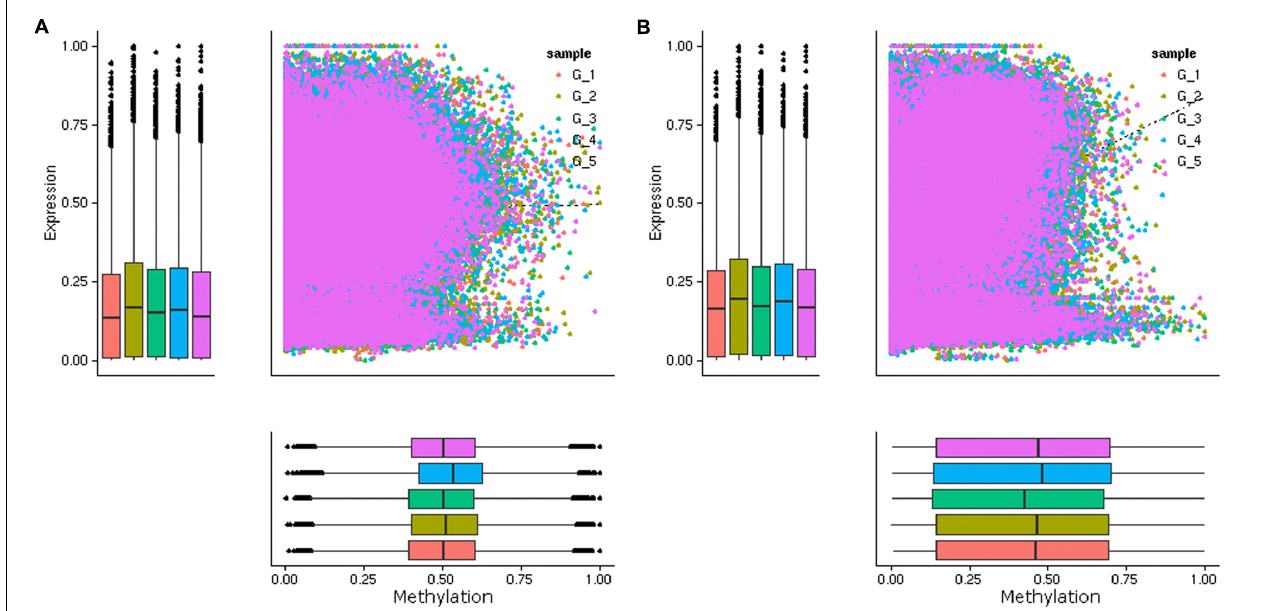
FIGURE 3 | Scatterplot of DNA methylation ( x -axis) and gene expression ( y -axis) of the DMRs overlapped genes in five groups (G1, G2, G3, G4, and G5). The genes with DMRs in the promoter regions (A) and the gene body regions (B) were presented. A overall positive correlation was observed between the methylation levels in the gene body and the mRNA expression levels of these DMRs overlapped genes, while a overall negative correlation between the methylation levels in the promoter regions and the mRNA expression levels was not observed.